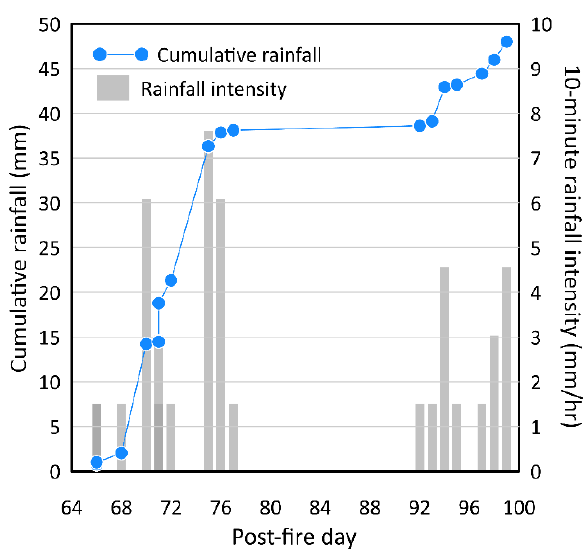
Figure 2. Cumulative rainfall precipitation and rainfall intensity during the study period from the onsite rain gauge at the Mesa Fire.